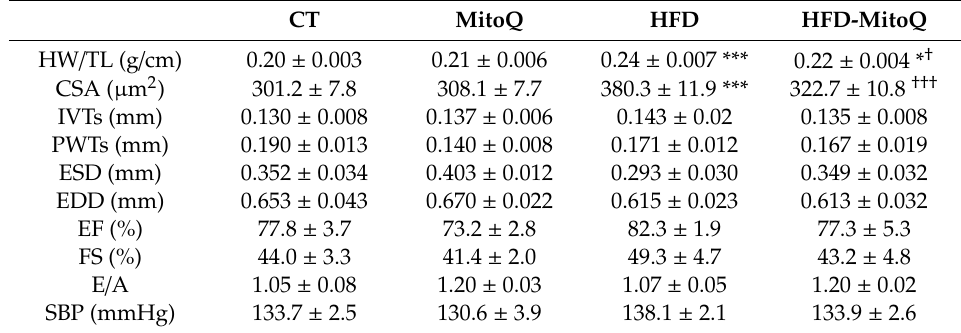
Table 1. E ff ect of the antioxidant mitochondrial MitoQ (200 µ M) on relative heart weight, cardiomyocyte cross-sectional area, echocardiographic parameters, and systolic blood pressure in rats fed a normal chow (CT) and rats fed a high fat diet (HFD).